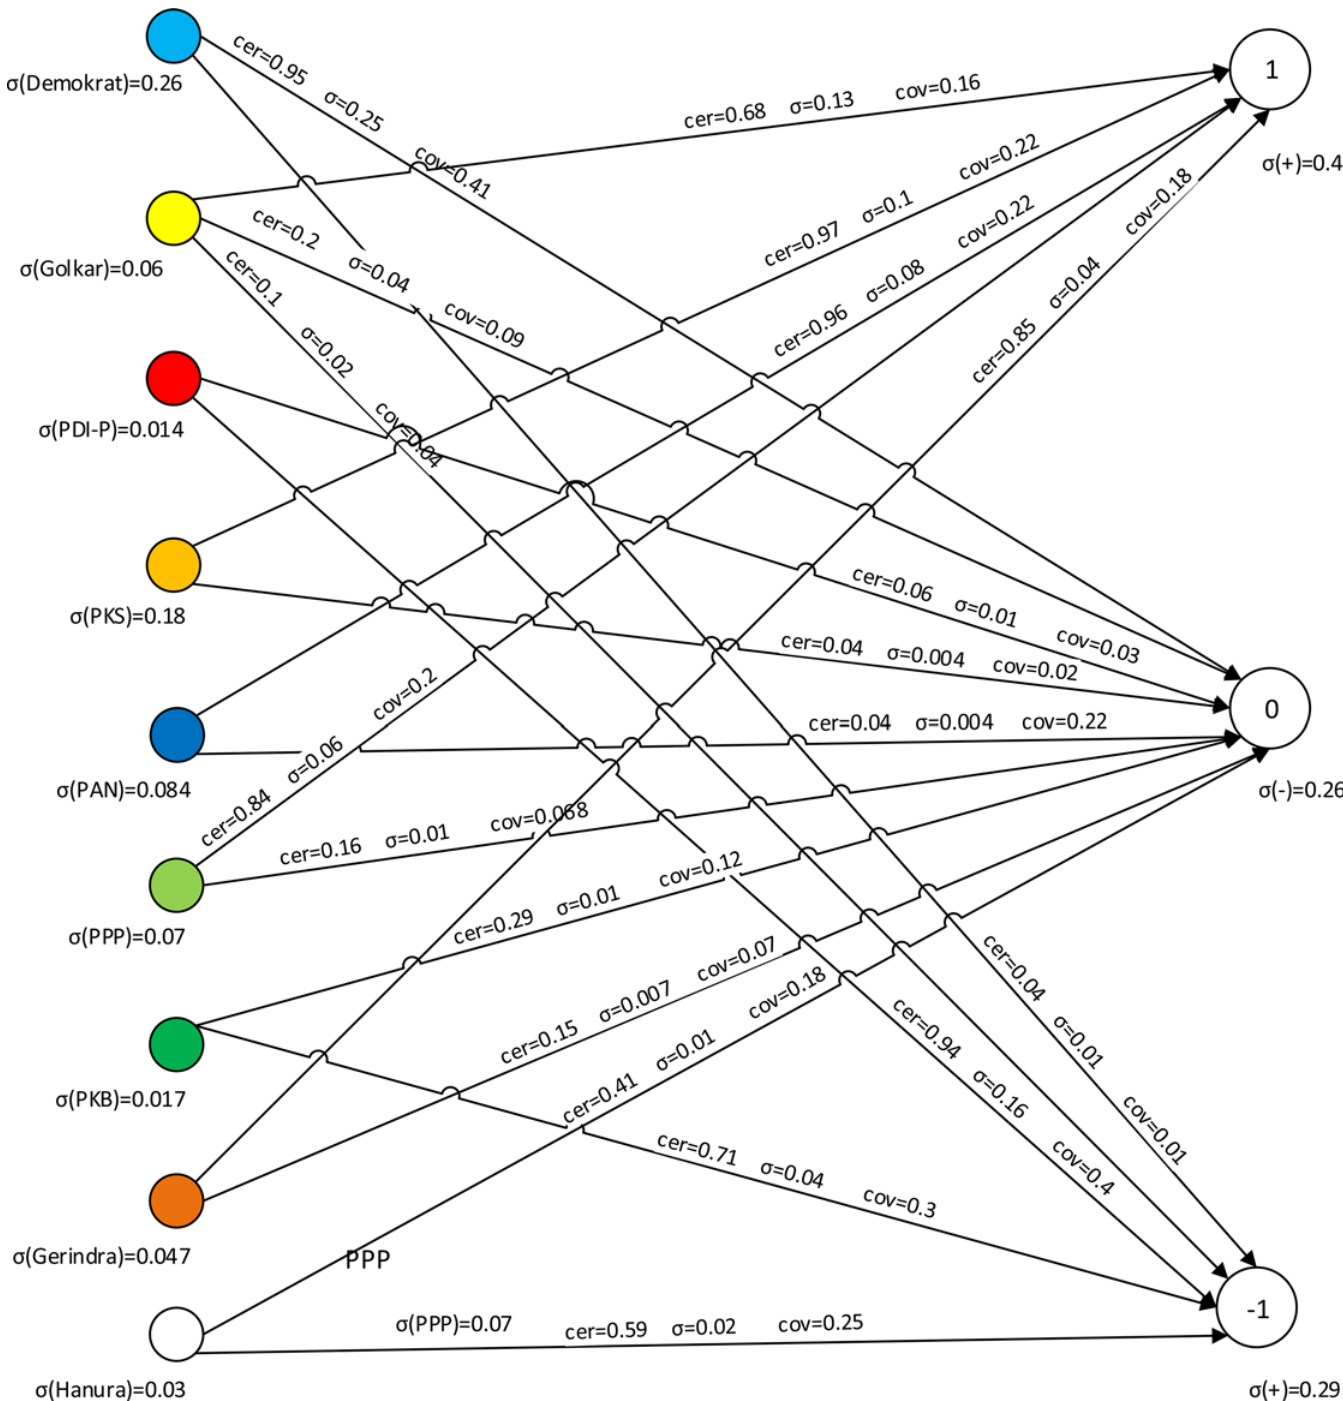
Fig 9. Flow graph for Table